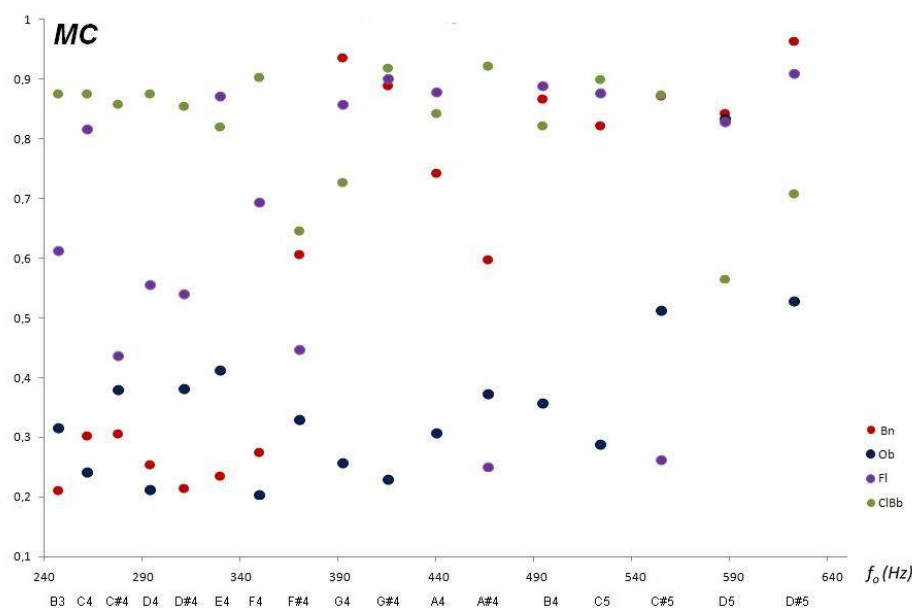
Figure 14. Mean contrast ( MC ) of the instruments studied for common tessituras.